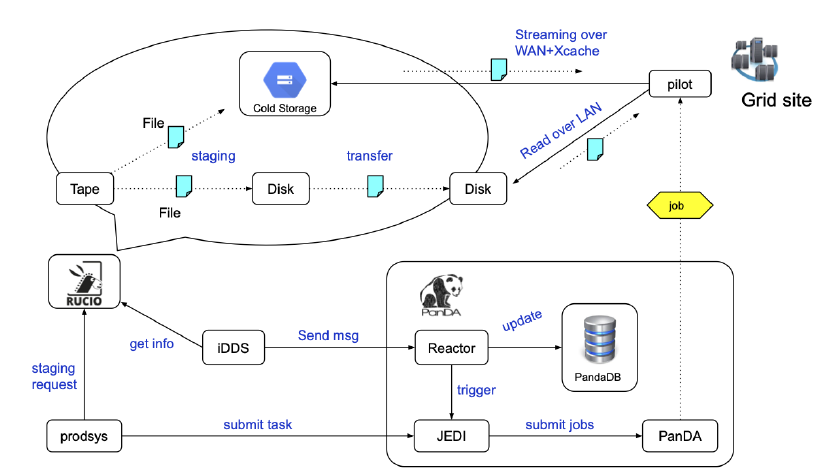
Table 1: Stable Rucio tape throughput for the ATLAS Tier-1 sites and CERN, measured from the 2020 reprocessing campaign, with comparison to the Phase I results.